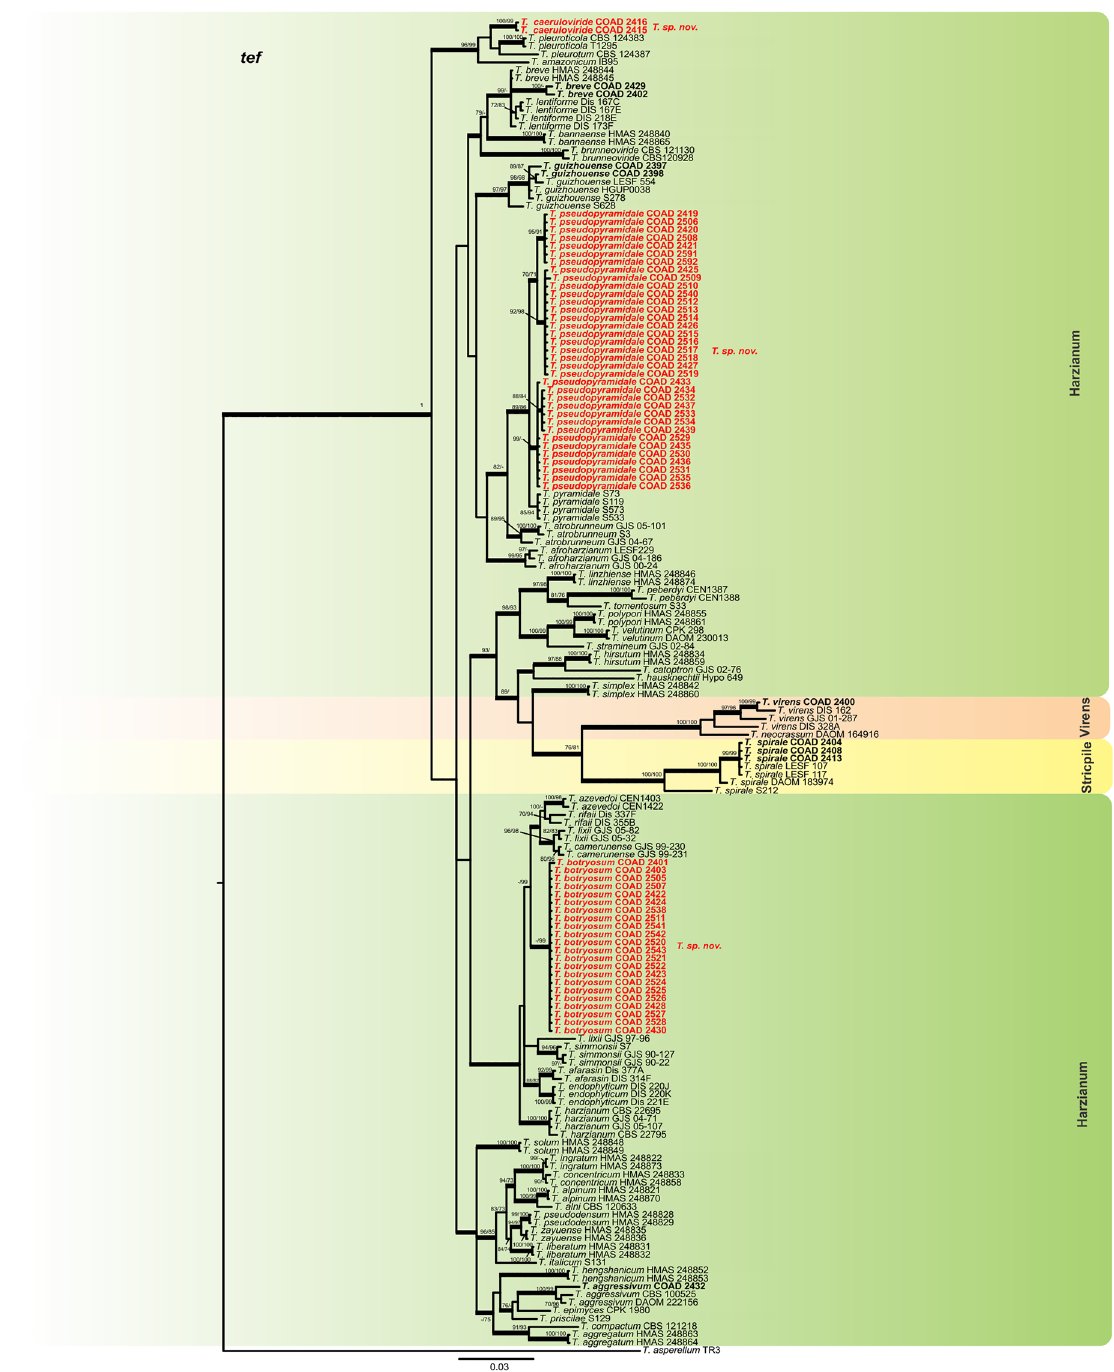
Figure 4. Bayesian phylogenetic tree of clades Harzianum , Strictipile and Virens . The tree was based on tef1 sequence dataset. Bootstrap values (≥ 70%) of the ML analyses, as well as posterior probability scores (≥ 0.9) from a Bayesian analysis of the same dataset, are indicated at well supported nodes together with thickened branches. The isolates belonging to known species, obtained in this study are in bold. Isolates of new species, described in this study, are in bold red. The tree was rooted with Trichoderma asperellum (TR3). The phylogenetic tree was edited using Inkscape 1.0 (https ://inksc